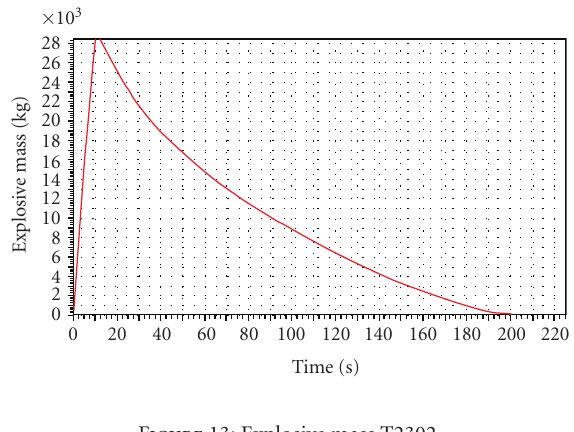
Figure 16: Structural damage using ExTool threshold values for scenario